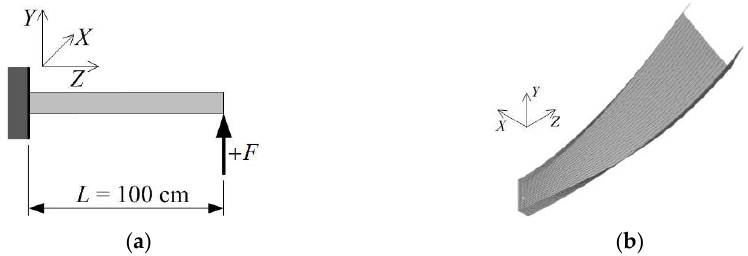
Figure 6. Cantilever beam: ( a ) geometry and ( b ) lateral-torsional buckling mode. Table 2. Example 2 ’s cross-section properties.